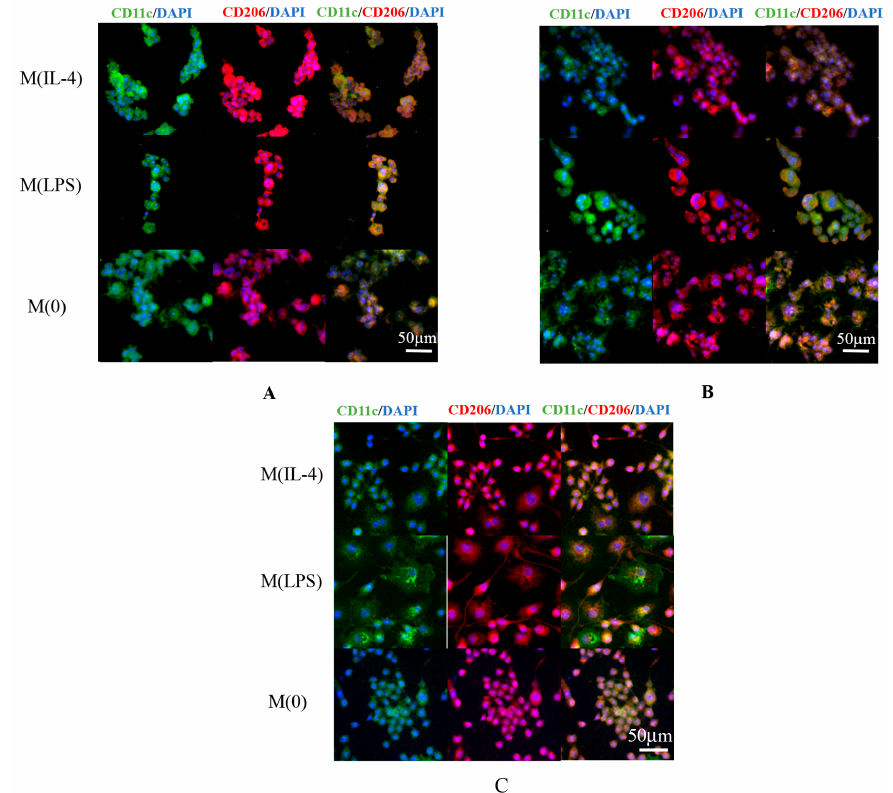
Figure 5. Immunocytochemistry staining of macrophages suggests that modified alginates alter phenotype: ( A ) nitro/epoxide; and ( B ) ester/amide modified alginates were coated on cells; and ( C ) cells in the absence of alginate are shown for comparison. Cells were stained with fluorescently labeled CD206 (red, M2 marker) and CD11c (green, M1 marker) markers as well as DAPI (blue). Scale bar is 50 μ m.